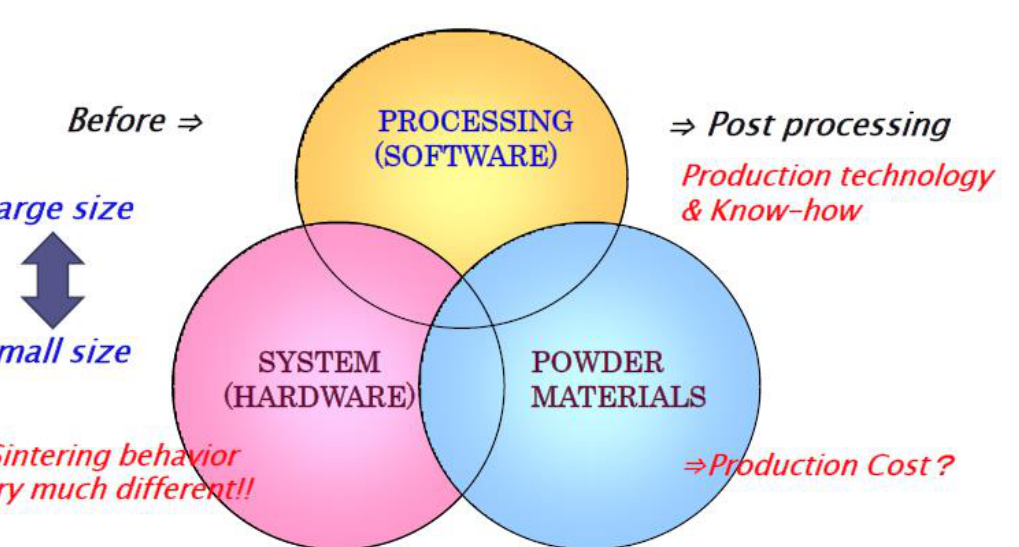
Figure 50. Recent demands on SPS technology from industries.